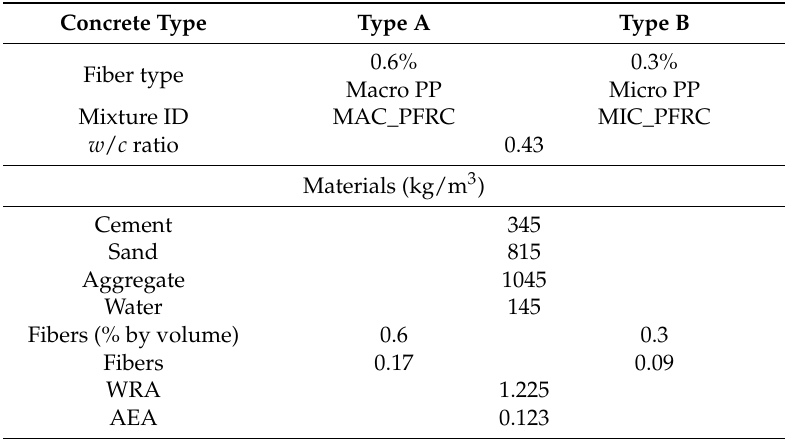
Table 4. Mixture Proportions for